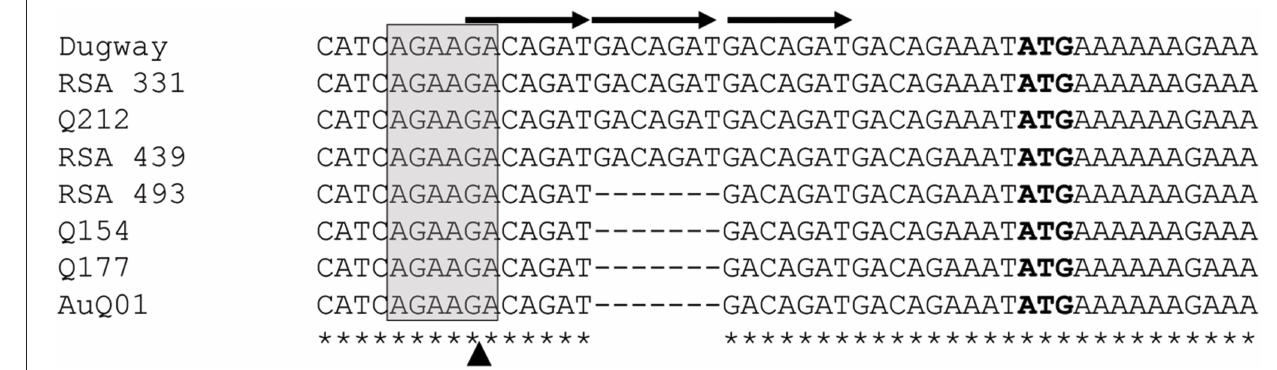
FIGURE 6 | Multiple sequence alignment of the 5 ′ region of C. burnetii ’s IVS. Corresponding sequences of selected C. burnetii strains (shown on the left; see Table S2) were aligned using ClustalX. Bases in the gray box represent a potential SD region. Arrows indicate direct heptameric repeats, while a dashed line shows deletion of one of the repeats. ATG (in bold) represents the start codon of the S23p ORF, as predicted by Afseth et al. (1995). An asterisk indicates perfect nucleotide sequence identity in the alignment. The arrowhead indicates the RNase III 5 ′ processing site.